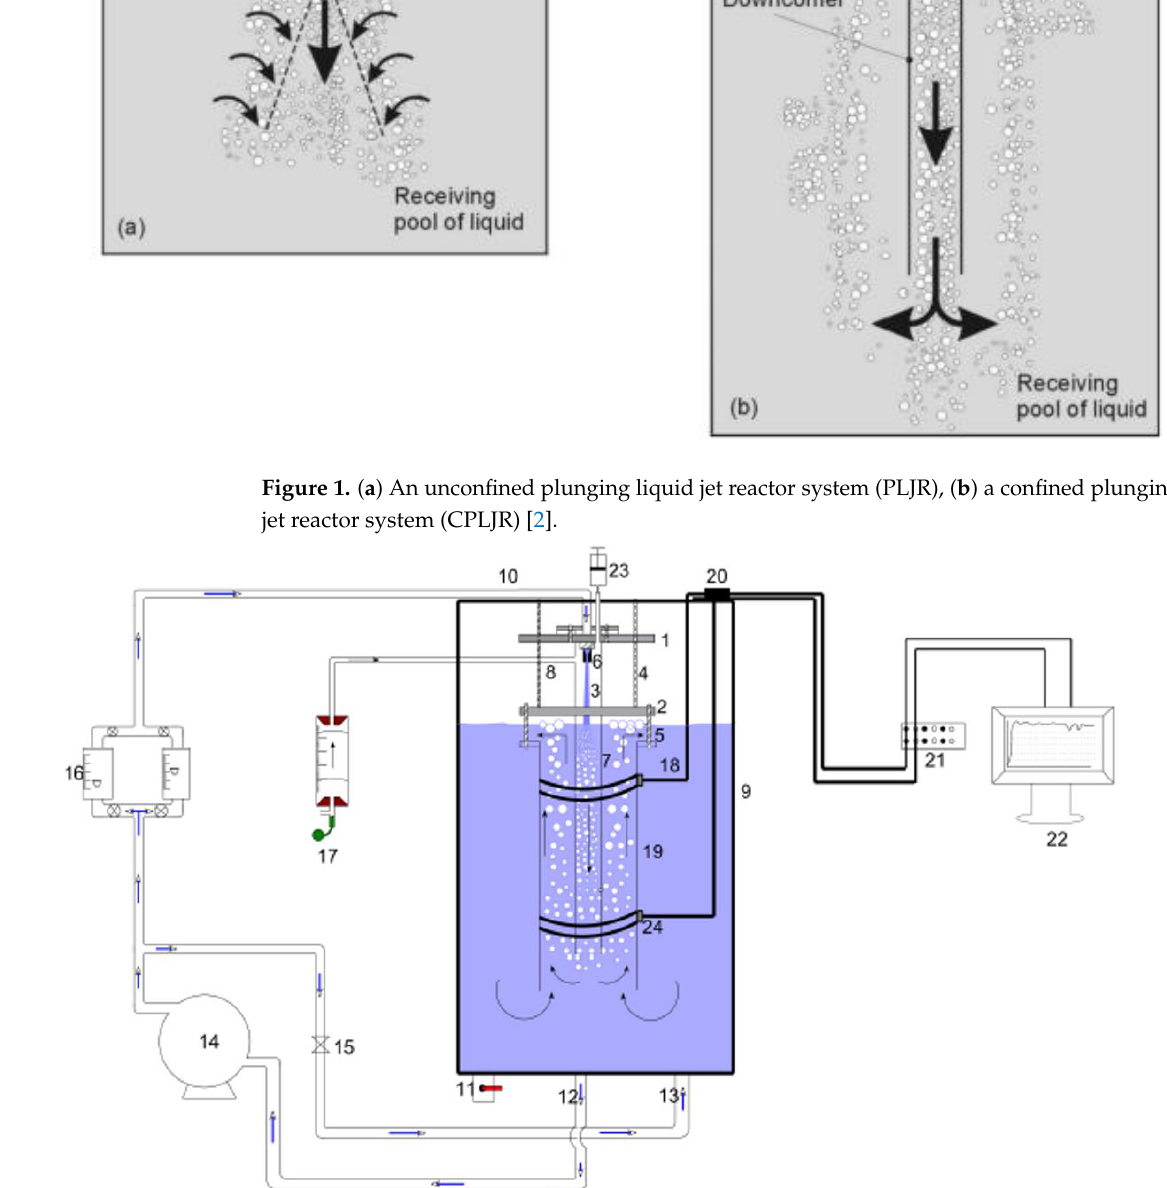
Figure 2. Schematic diagram of the air-lift column in the confined plunging liquid jet reactor: (1) top flange, (2) bottom flange, (3) liquid jet, (4) supporting rods, (5) riser rods, (6) nozzle, (7) downcomer, (8) air tapping, (9) water tank, (10) water supply, (11) drain, (12) recycled water, (13) bypass, (14) pump, (15) valve, (16) rotameter, (17) bubble meter, (18) wires, (19) annulus, (20) connection point, (21) amplifier, (22) PC, (23) injecting salt by syringes, (24) electrodes [2,4].